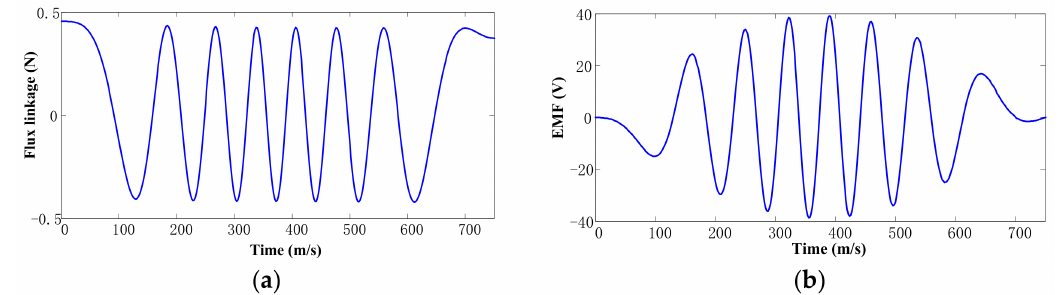
Figure 9. TPMLG waveforms at sine velocity: ( a ) flux linkage and ( b ) EMF waveforms.